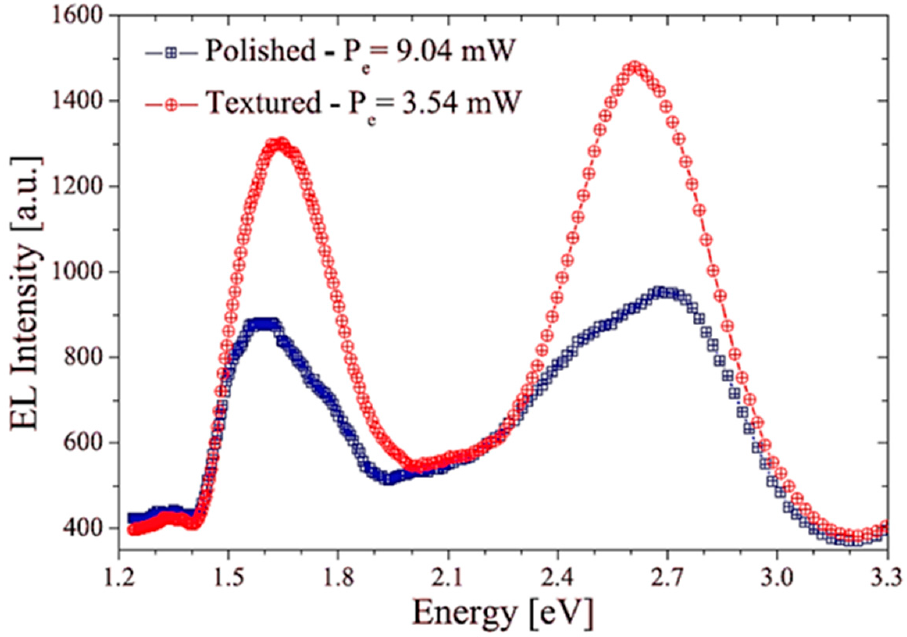
Figure 5. EL spectra of LECs with polished and textured Si substrate. The two main peaks expected in single layer SRO LECs are clearly identified. However, an improvement of the emission intensity of almost twice is observed in textured substrate, and lower electric power is required [30]. Additional promising results with texturized substrates were also found in devices in which the process was performed by MACE. In this method, metal particles are deposited on the Si surface followed by an etching process in a HF-oxidant based solution [32,33]. The Si beneath the metal particles is oxidized by the solution and then removed due to the presence of HF, leaving a textured surface with an average roughness of 7.5 nm. Figure 6 displays the integrated EL intensity as function of the electric field applied to the LECs both polished and